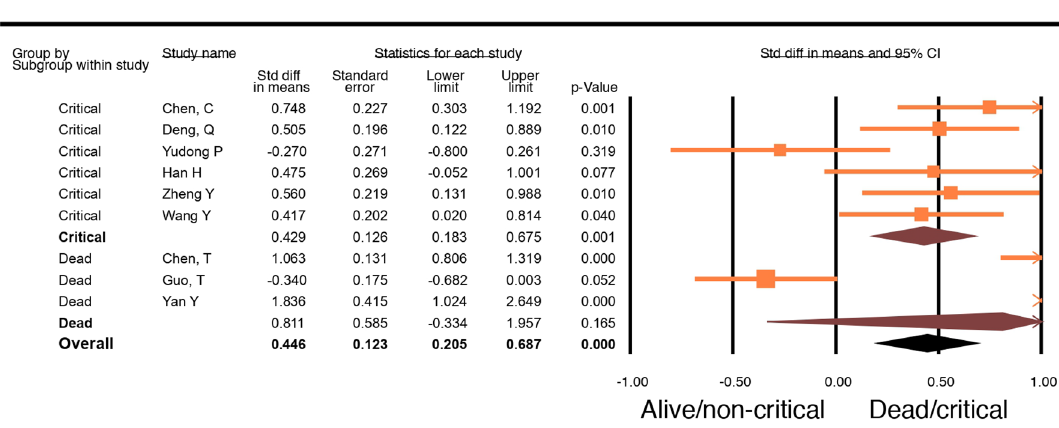
Figure 2. Forest plot of WMD in troponin between alive and/or not critically ill patients and dead and/or critically ill patients with COVID-19.